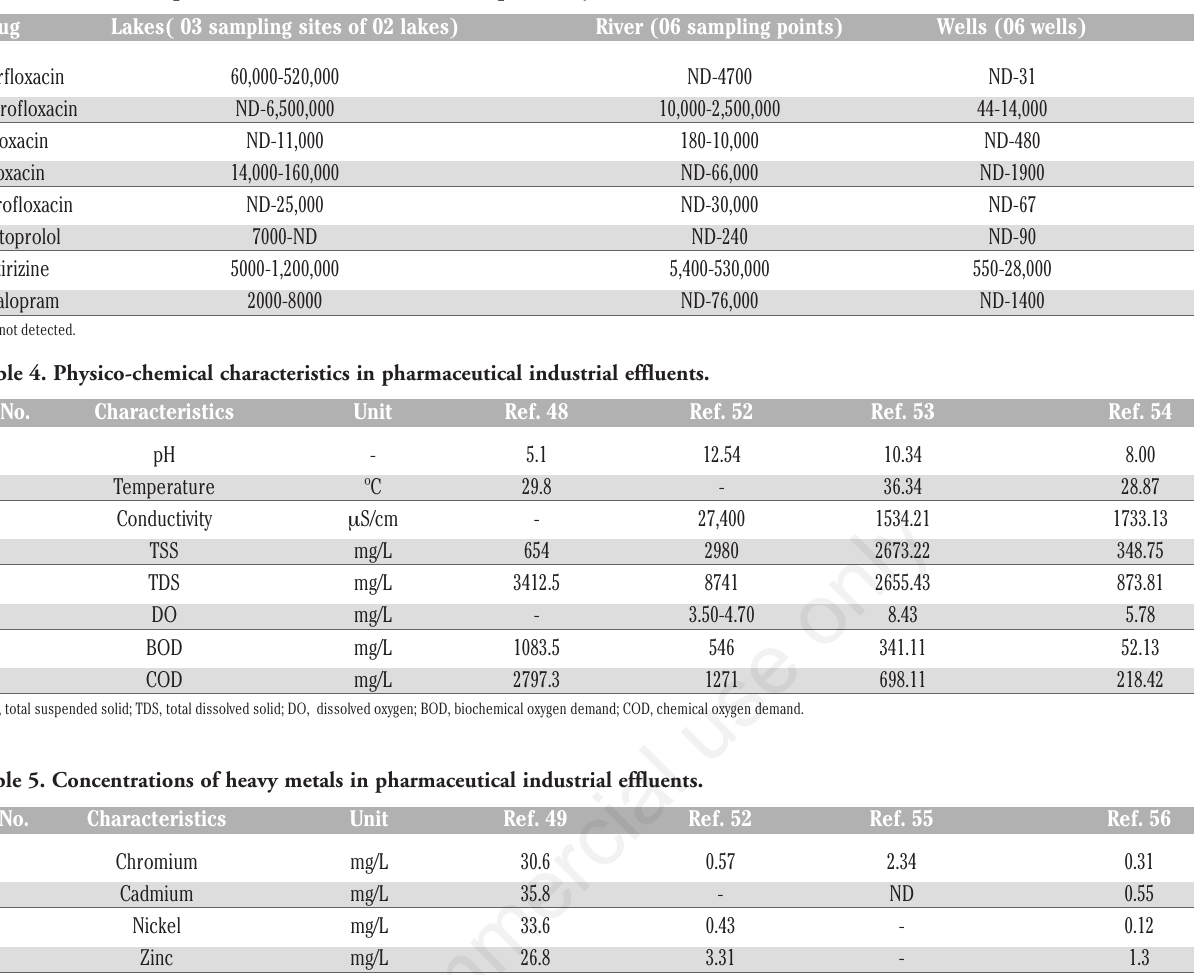
Table 3. Detection of pharmaceuticals in fresh water samples in Hyderabad area, India. Drug